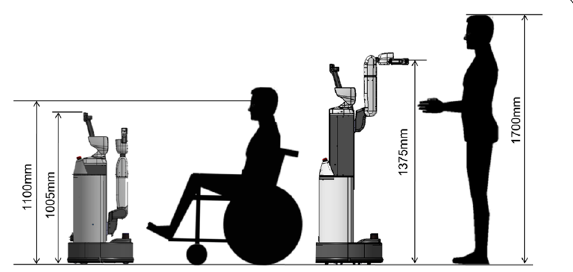
Fig. 10 Side view of HSR, person standing and riding wheelchair